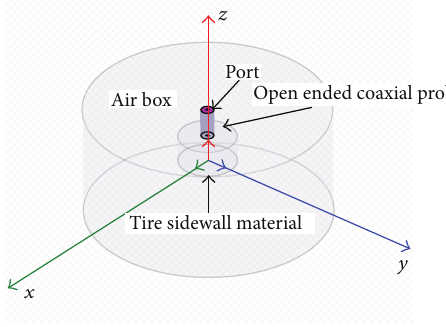
Figure 5: OCP model based on